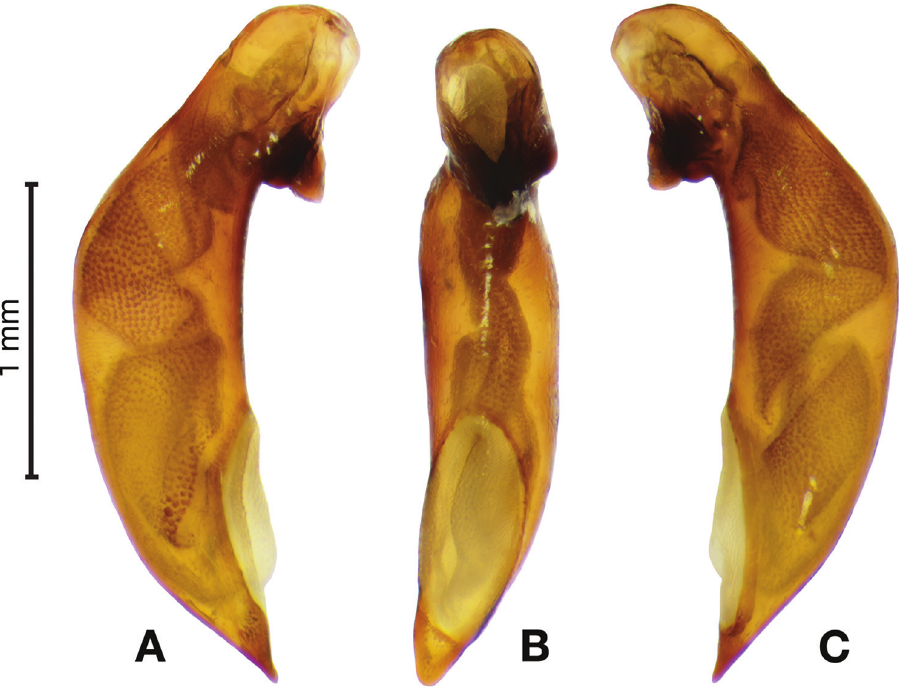
Figure 43. Digital images of male genitalia of C. ( Coptoderina ) japonica Bates. A right lateral aspect B ventral aspect C left lateral